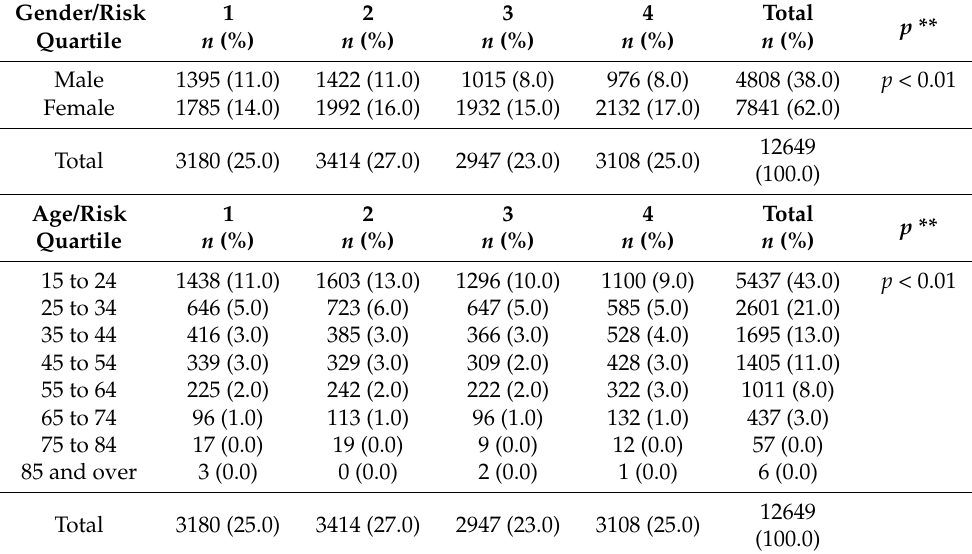
Table 1. Population distribution by quartiles of risk, gender and age.